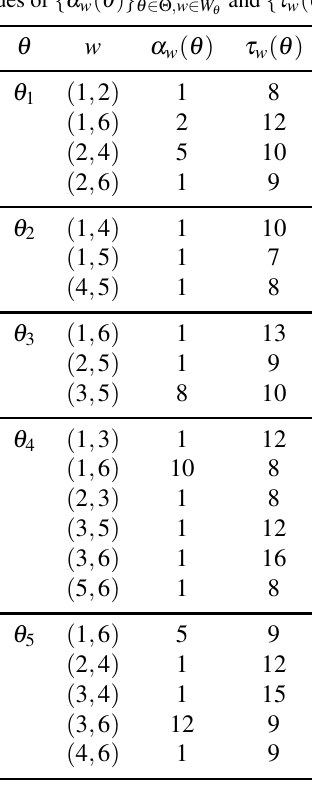
and { τ w ( θ ) } θ ∈ Θ , w ∈ W θ